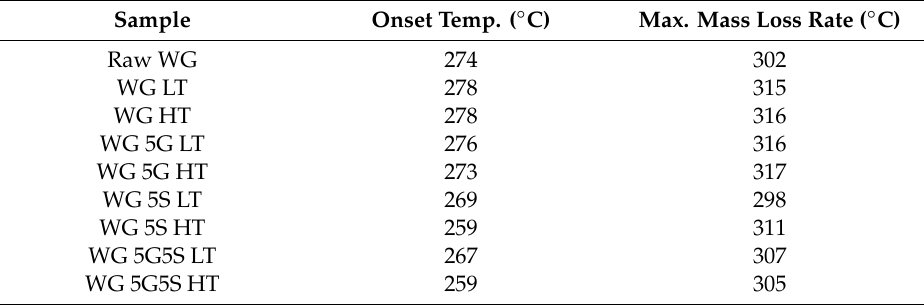
Figure 6. Thermal stability of the samples (left) and first derivative (right). The curves were stacked for clarity. Table 3. Summary of the thermal properties obtained from the TGA